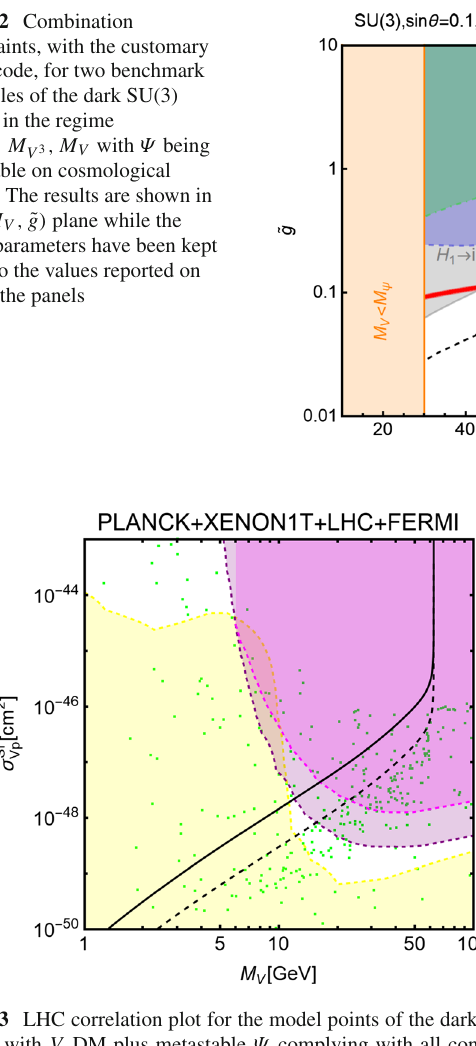
Fig. 23 LHC correlation plot for the model points of the dark SU ( 3 ) model with V DM plus metastable Ψ complying with all constraints and featuring, as well, 2 . 5% ≤ BR ( H 1 → inv ) ≤ 11%. The solid (dashed) contours represent the predicted cross sections of the effective vector Higgs-portal corresponding to BR ( H 1 → inv ) = 11% ( 2 . 5% ) . The magenta/purple regions represent future sensitivities from XENONnT/DARWIN and the yellow ones the neutrino floor